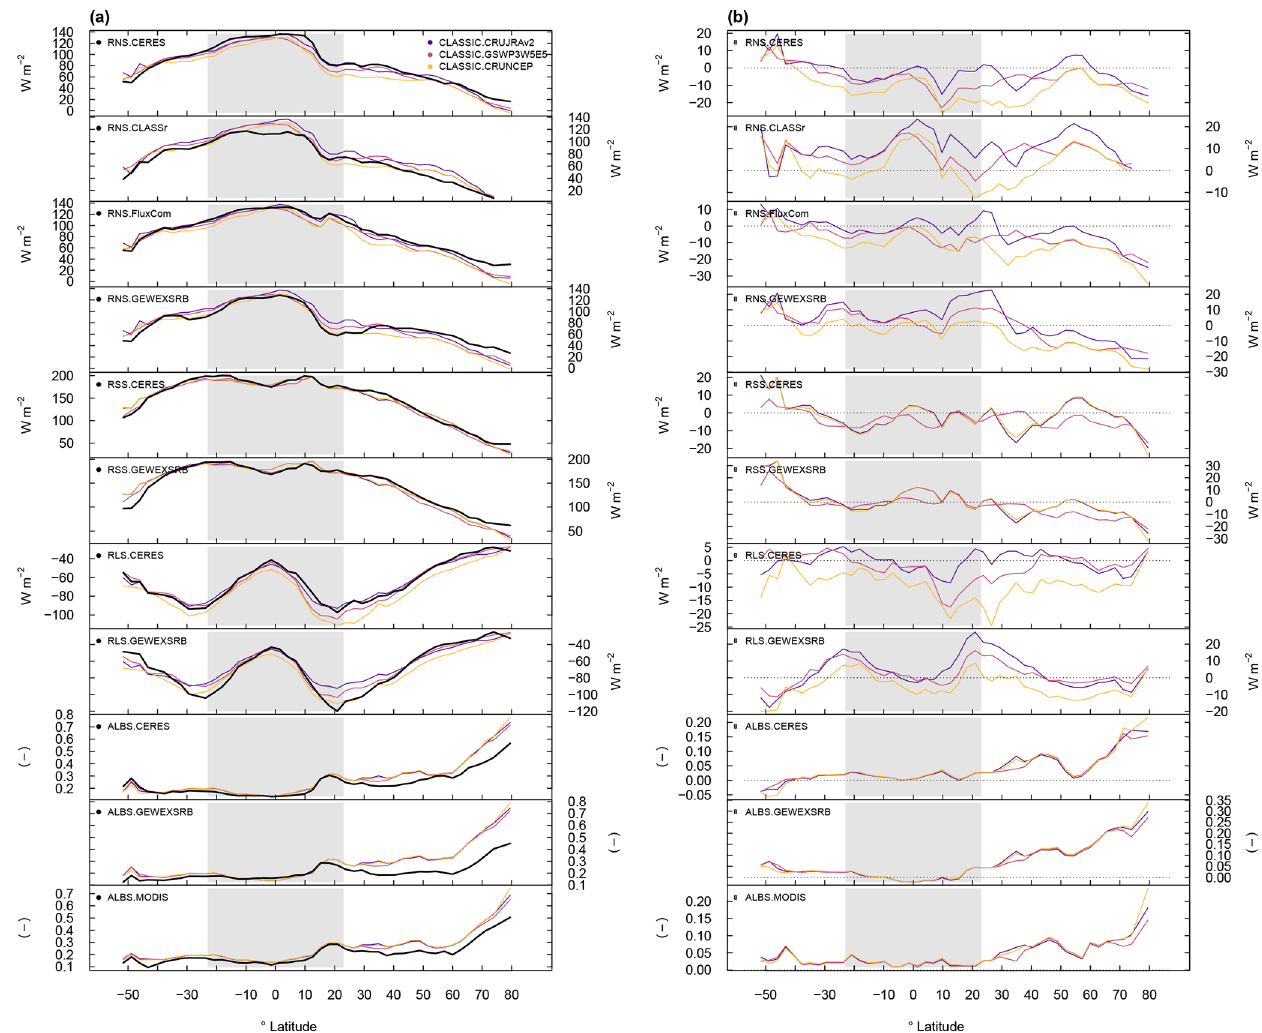
Figure 6. (a) Zonal mean values and (b) corresponding biases for variables related to the radiation cycle.